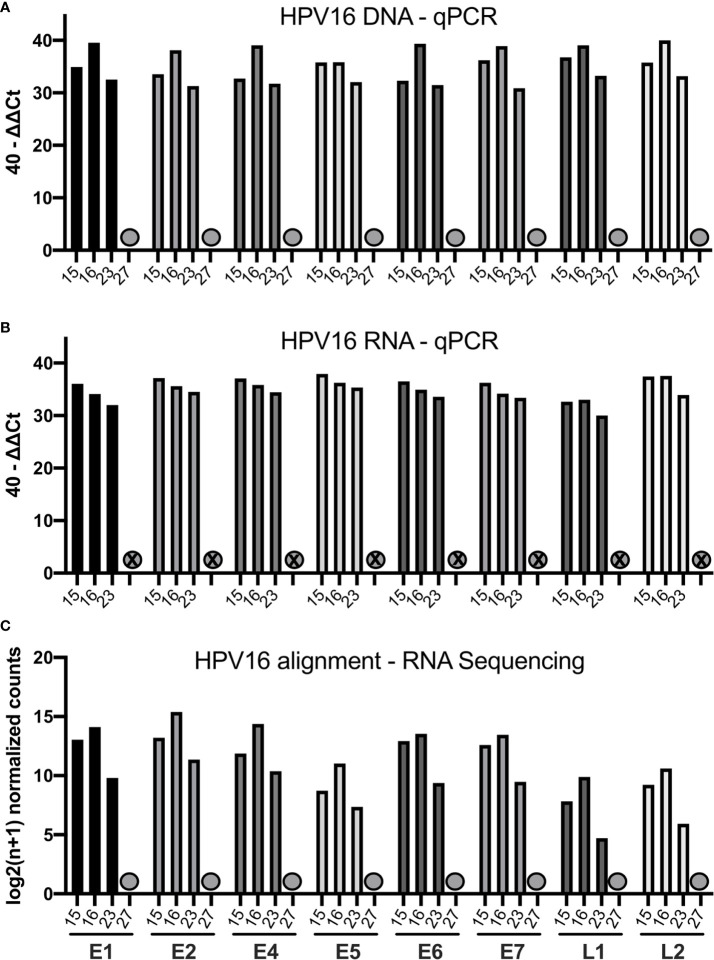
Bar graphs showing the qPCR and RNA-sequencing data of four selected patients (15, 16, 23, 27). (A) Bar graph displaying 40-ΔΔCT values of DNA for all HPV16 genes of those patients. The HPV16neg (false p16 positive case 27) is marked with a grey dot. (B) Bar graph showing the corresponding 40-ΔΔCT values of RNA for the respective patients (C) Bar graph showing the log2(n+1) normalized counts for the HPV16 genome using RNA-sequencing data of respective patients.